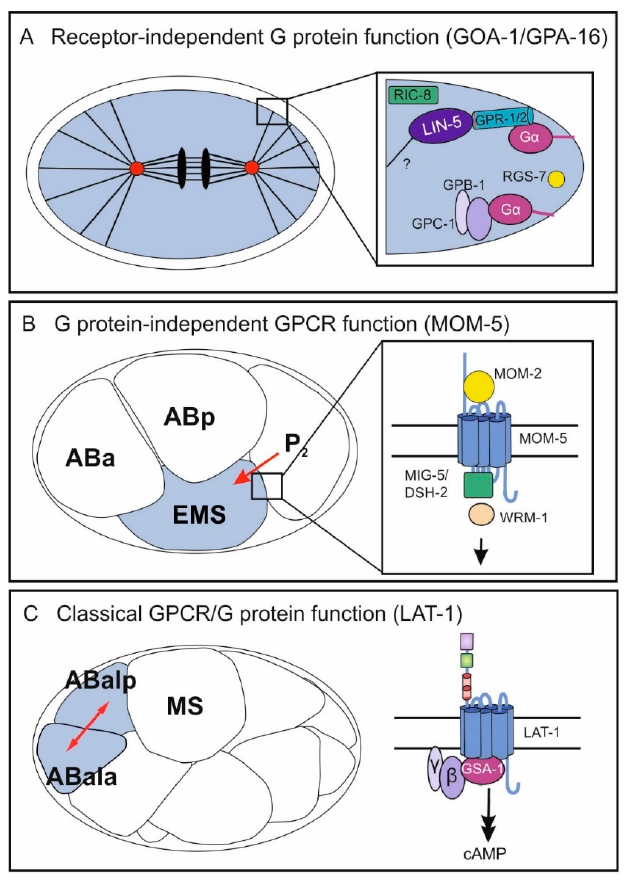
Figure 2. Independent and classical functions of GPCRs/G proteins in different processes during C. elegans embryonic development. In the early embryo, all three mechanisms occur in different biological contexts: the receptor-independent G-protein function (GOA-1/GPA-16) ( A ), the G protein-independent GPCR function (MOM-5) ( B ), and the classical GPCR/G protein pathway ( C ). ( A ) GOA-1 and GPA-1 control pulling force on astral microtubules leading to two asymmetric cells after the first division. The G α proteins function in a ternary complex with GPR-1/GPR-2 and LIN-5 and are modulated by the GEF RIC-8 and the RGS RGS-7. Further, the G β and G γ subunits GPB-1 and GPC-1 are hypothesized to contribute to regulation of pulling forces. ( B ) The Frizzled class GPCR MOM-5 mediates a signal from the P 2 blastomere polarizing the neighboring EMS cell. Upon activation by the Wnt ligand MOM-2, MOM-5 activates the disheveled homologs MIG-5/DSH-2 and subsequently involves the β -catenin WRM-1. Note that asymmetric localization of the different components is not depicted. ( C ) A classical GPCR/G protein pathway in embryonic development is realized by the Adhesion GPCR LAT-1, which controls anterior–posterior cell division of several blastomeres including ABal. LAT-1 activates the Gs pathway via the G α protein GSA-1 yielding an increase in the second messenger cAMP. For the physiological relevance of each GPCR/G-protein function, see Section 1. Mechanistic details are discussed in Sections 2 and